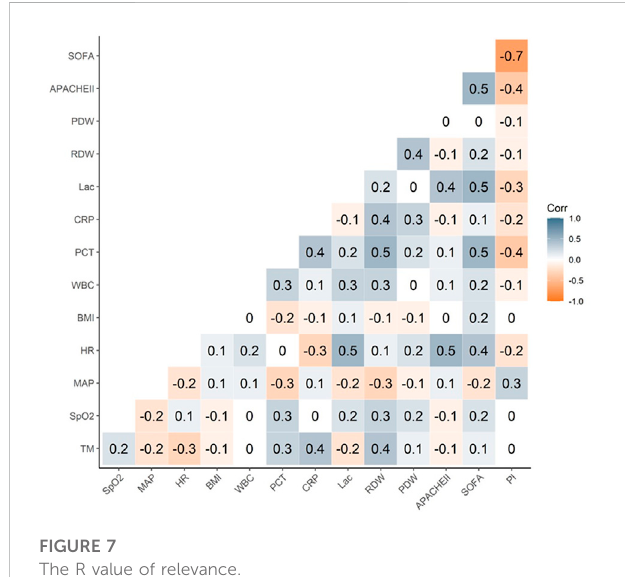
FIGURE 7 The R value of